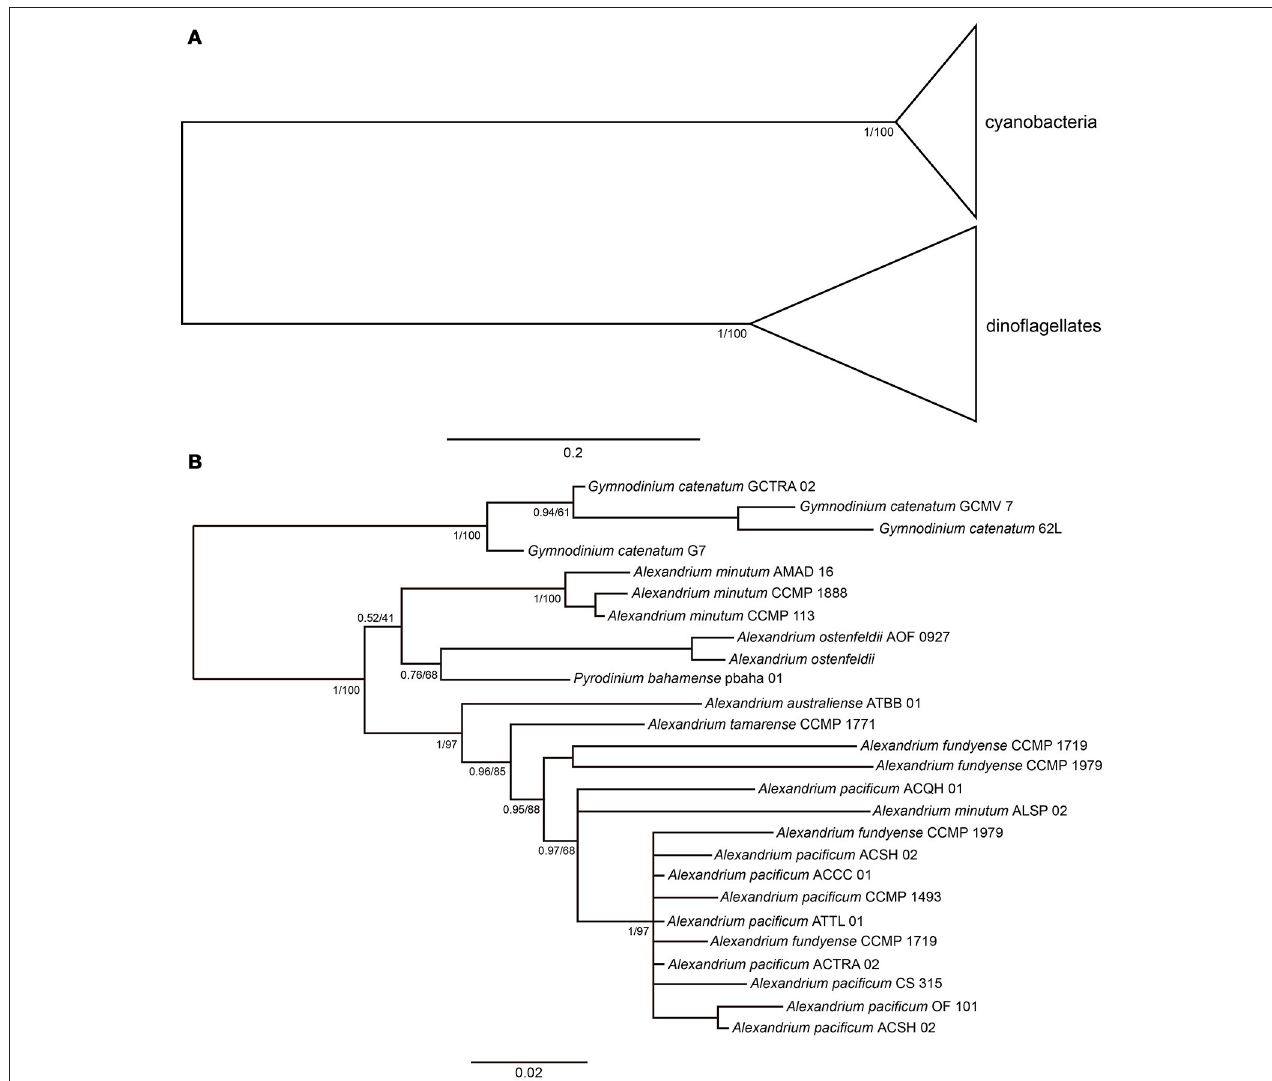
FIGURE 3 | (A) Phylogenetic tree of sxtA4 domain of cyanobacteria and dinoflagellates, the node labels indicate the posterior probabilities and bootstrap values. (B) Phylogenetic tree of sxtA4 domain of dinoflagellates, the tree was reconstructed by Bayesian Inference, the node labels indicate the posterior probabilities and bootstrap